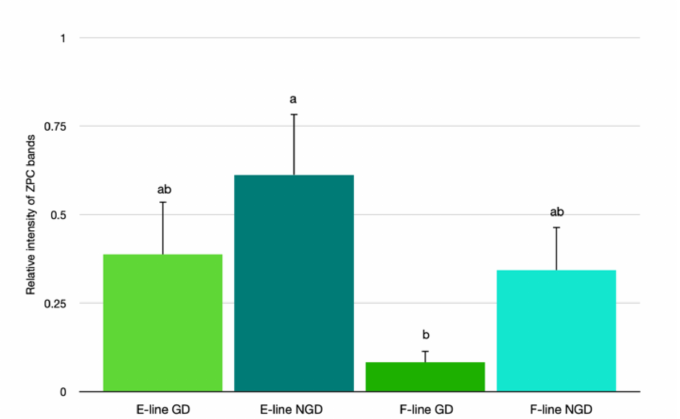
Figure 4. Relative abundance of ZPC protein in the germinal disc (GD) or the non-germinal disc (NGD) region of the perivitelline layer from two genetic lines of turkeys selected for egg production (E-line) or rapid body growth (F-line). Values represent the mean ± SEM. n = 6 replicates per sample. Means with different letters differ, p <